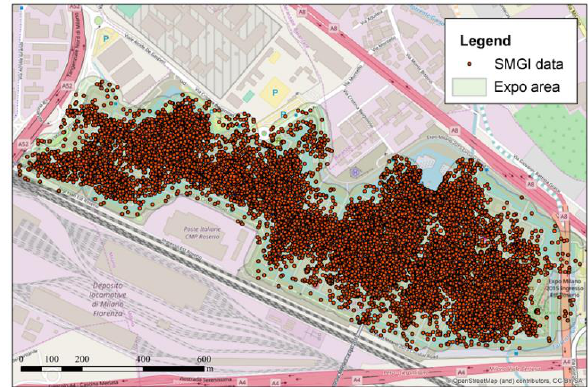
Figure 2. Dataset of points corresponding to Instagram posts referring to the Expo 2015 event, inside a 50 m buffer of the